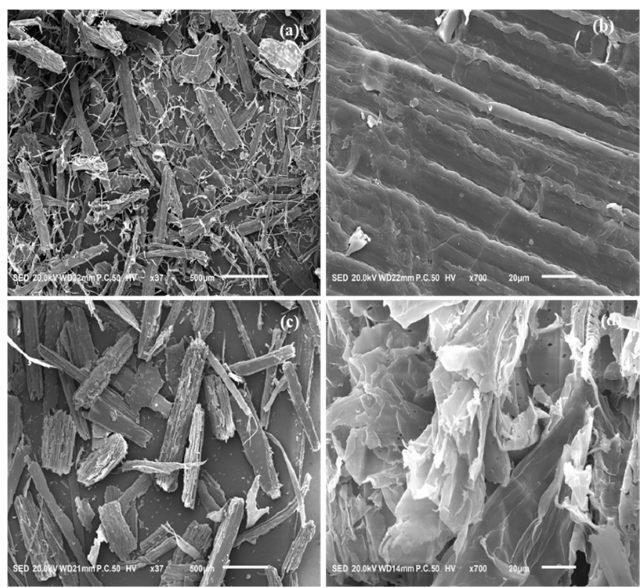
Figure 12. Surface morphology of untreated wheat straw and Na:EG-treated residue: ( a ) untreated wheat straw × 37, ( b ) untreated wheat straw × 700, ( c ) Na:EG-treated wheat straw × 37, and ( d ) Na:EG-treated wheat straw × 700.